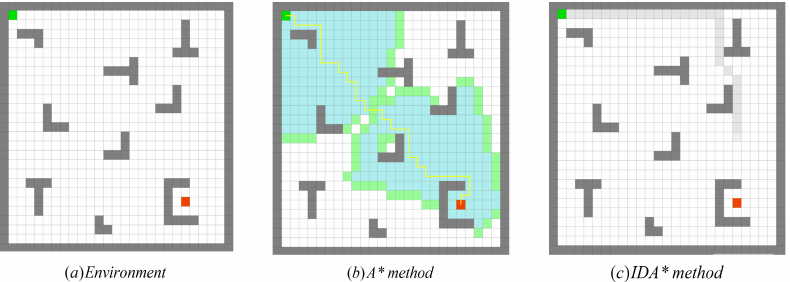
Figure 10. The experimental results of the search algorithm in a similar environment: ( a ) the experimental environment; ( b ) the planning result of the A* algorithm based on Euclidean distance (success); ( c ) the planning of the IDA* algorithm also based on the Euclidean distance result (failure).